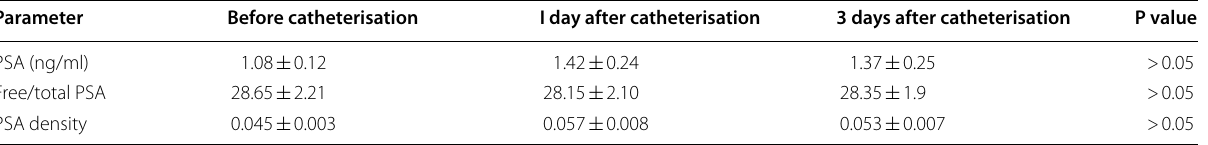
Table 1 PSA, PSA density and free/total PSA levels in Group A Parameter